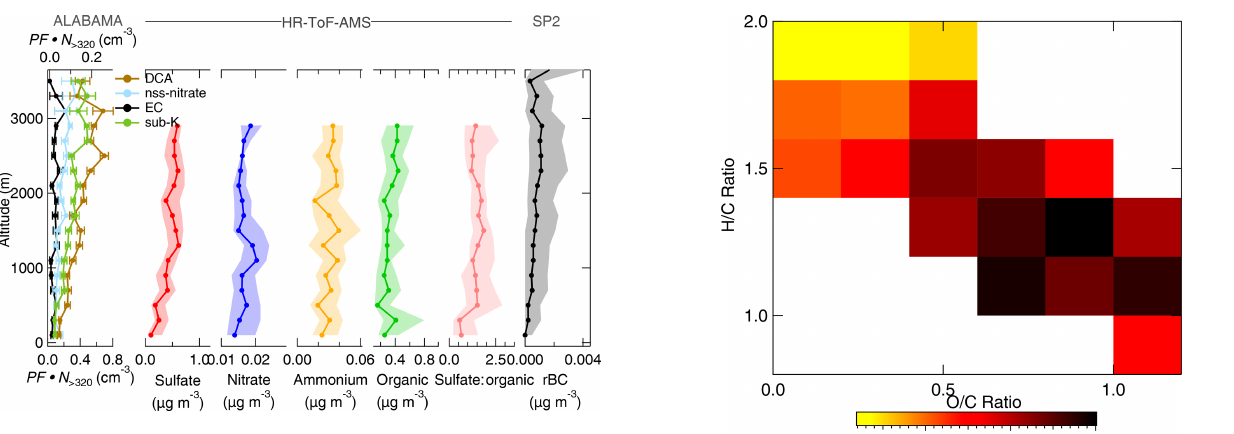
Figure 9. Vertically resolved aerosol composition measured by the ALABAMA, by the HR-ToF-AMS, and by the SP2 (indicated on the top side) during the Arctic air mass period. Note the differ- ent scales. The left panel represents the scaled ALABAMA num- ber concentration (PF · N > 320 ) with the top axis referring to EC- containing (black) and nss-nitrate-containing (light blue) particles and the bottom axis referring to DCA-containing (brown) and sub- K-containing (green) particles. The right panels represent each median (solid line with marker) and interquartile range (shaded area) of the HR-ToF-AMS mass concentrations of sulfate (red), ni- trate (blue), ammonium (orange), organic matter (light green), the sulfate-to-organic ratio (pink), as well as the SP2 mass concentra- tion of refractory black carbon (rBC) (black). Uncertainty analyses are given in Sect. S7.